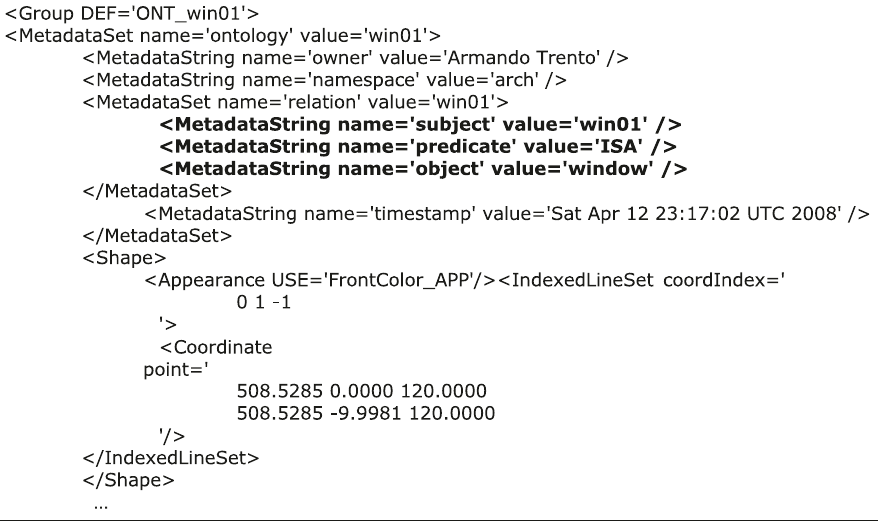
Figure 9: A snapshot of X3D.